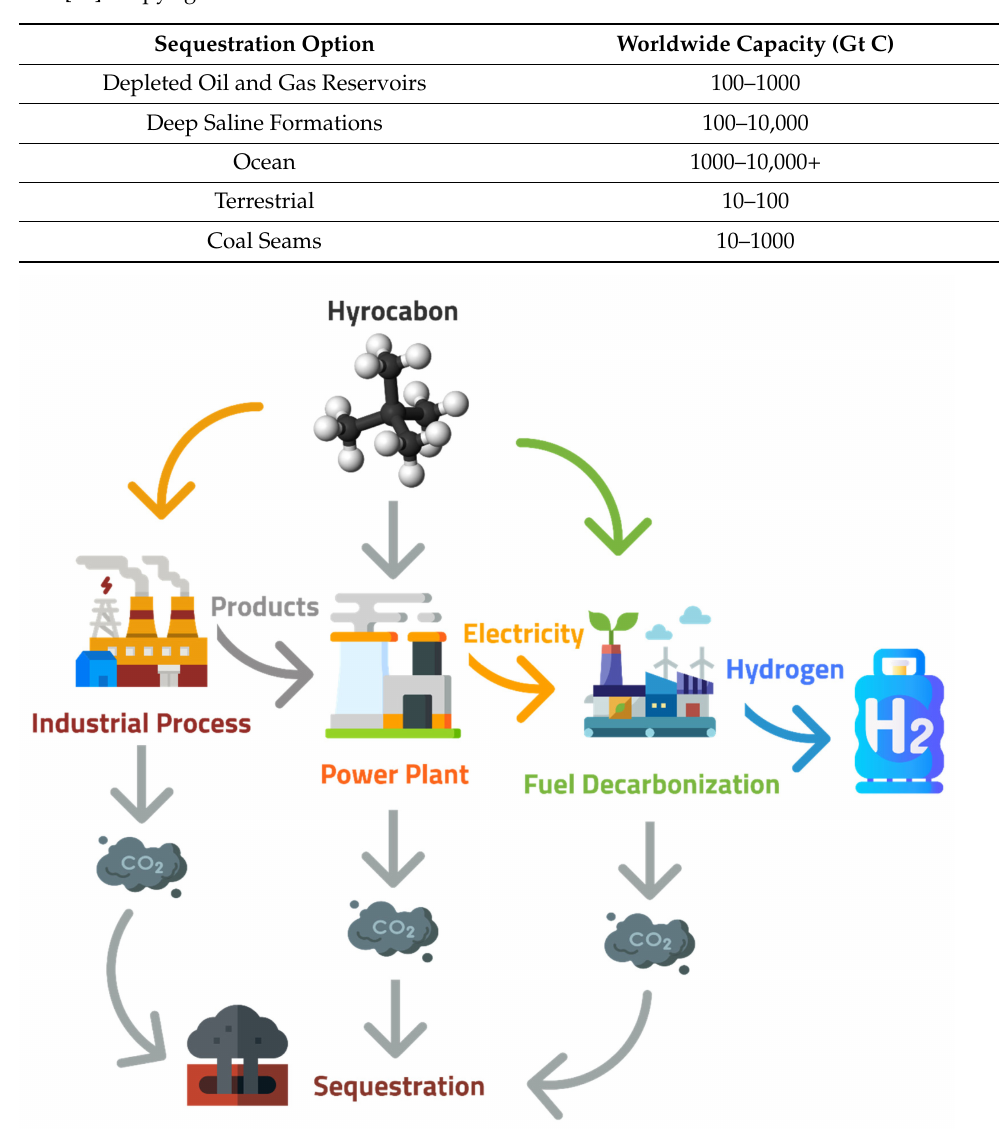
Figure 1. Sequestration sources of CO 2 captured from power plants are a byproduct of industry or decarbonization